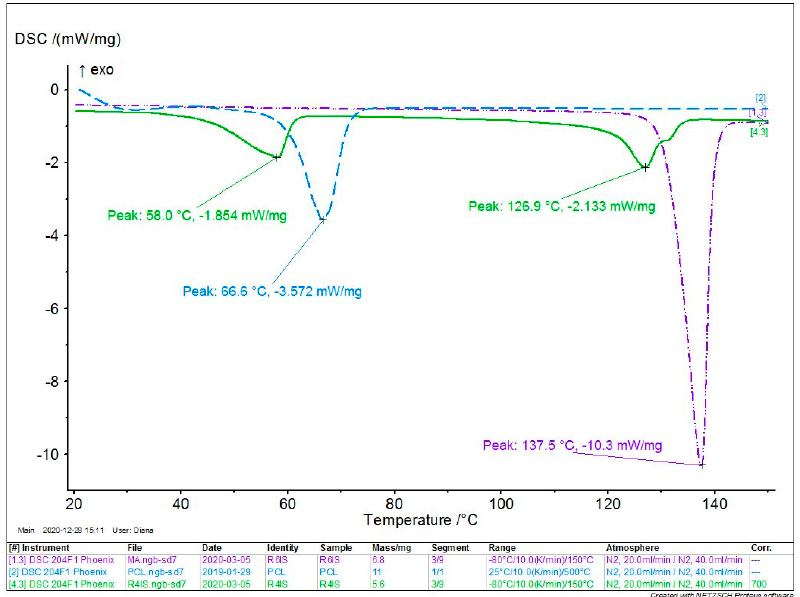
Figure 6. Differential scanning calorimetry characterization (DSC) curves of the ECL_MA co-polyesters (green line), PCL homopolymer (blue point line), and MA monomer (purple dashed line). The DSC thermograms registered after two heating cycles are presented in Figure S2. Table 5. Differential scanning calorimetry (DSC) parameters of the ECL_MA co-polyesters, PCL homopolymer, and MA